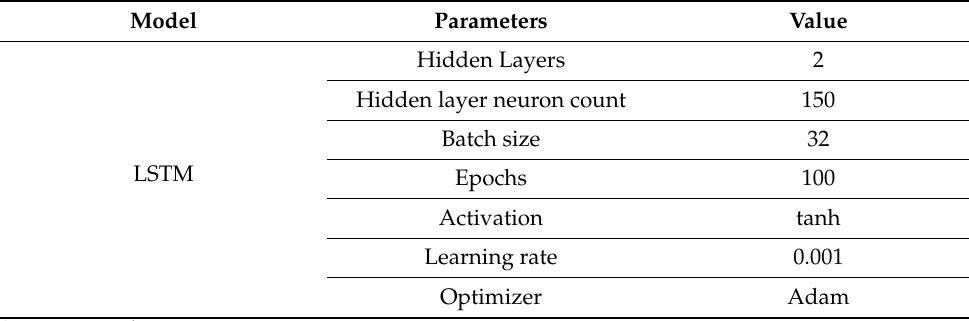
Table 5. Hyperparameters of LSTM